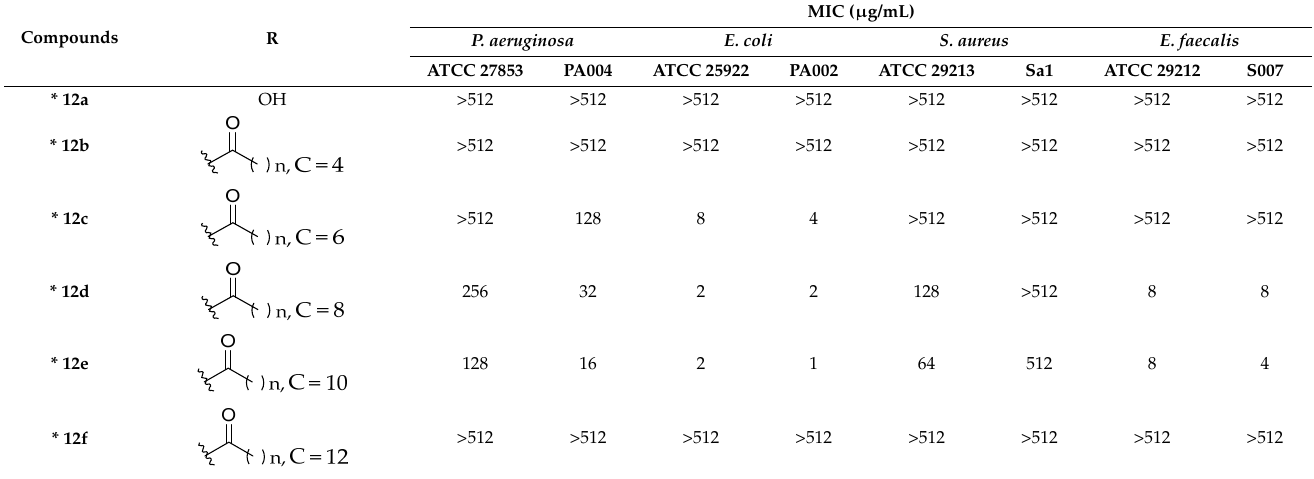
Figure 30. SAR analysis of flavonoids and their sulfonic derivatives as antibacterial agents [100]. Table 21. Antibacterial activities of anthocyanins bearing fatty acid moiety in sugar portion.